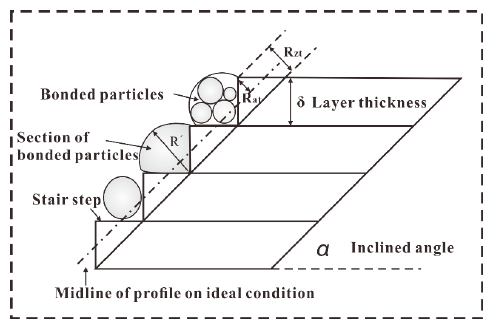
Figure 15. Schematic representation of influence of bonded particles or balling on the profile of upper surface.